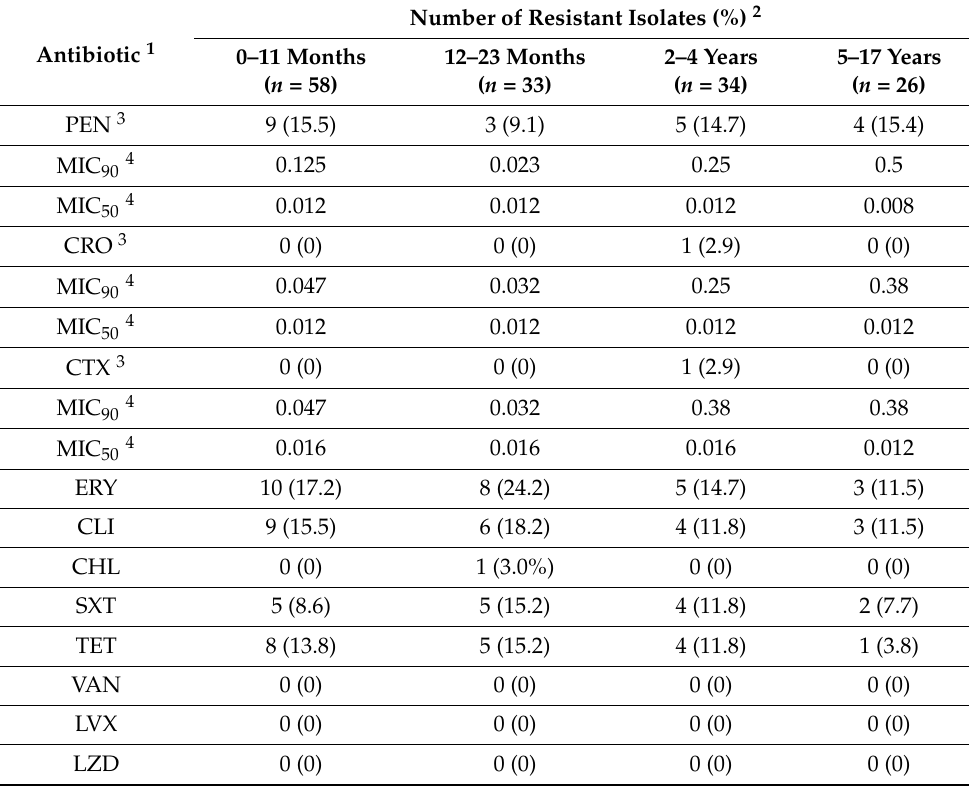
Table 3. Antimicrobial resistance of Streptococcus pneumoniae isolates responsible for invasive disease in patients <18 years, Portugal, July 2015–June 2018 ( n =